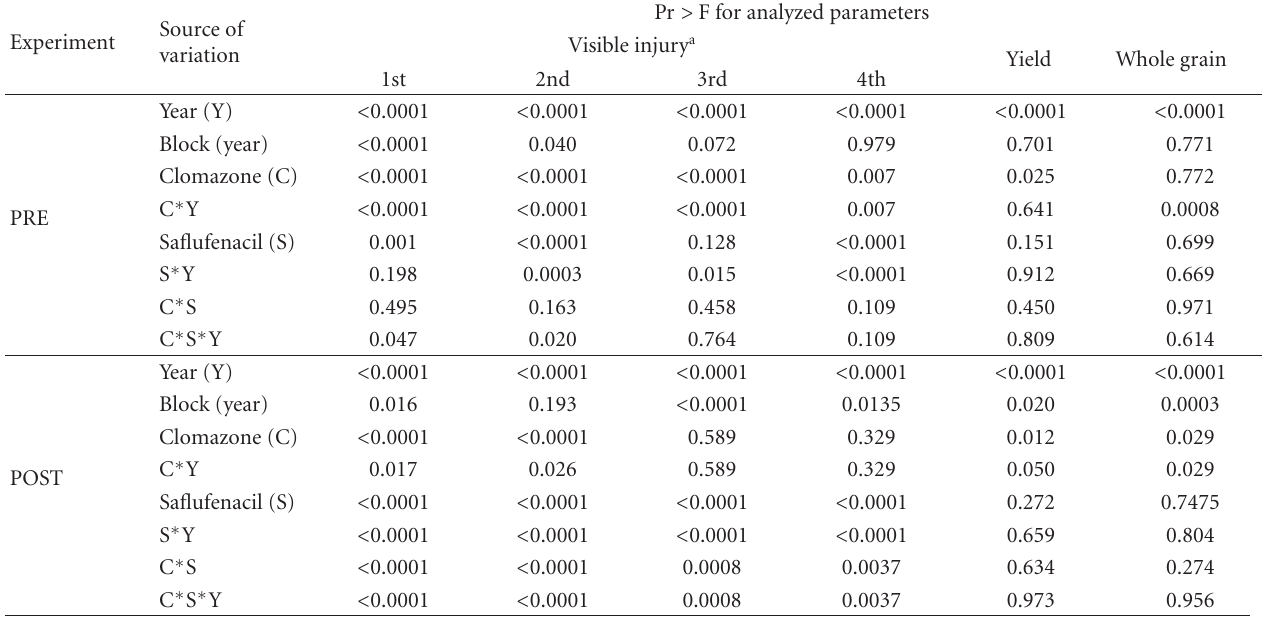
Table 1: P values for multiple assessments of visible injury, yield, and whole grain for preemergence (PRE) and postemergence (POST) applications of saflufenacil.